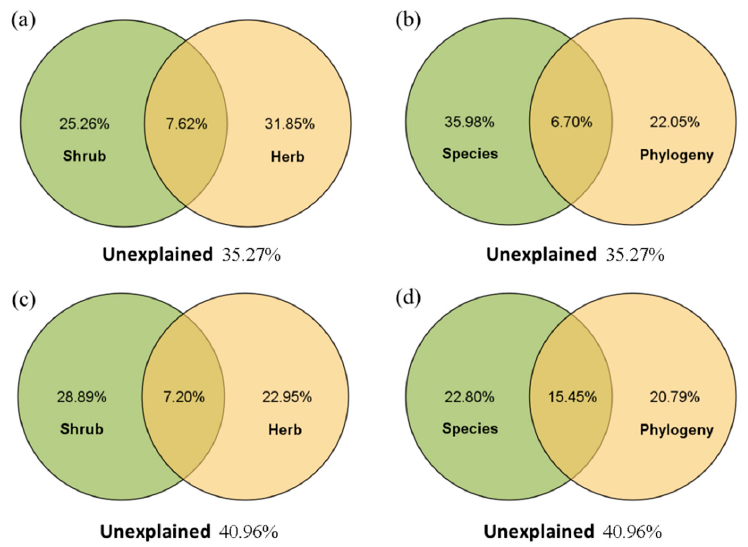
Figure 5. The variance component of soil nutrients explained by understory vegetation in the R. pseudoacacia forest ( a , b ) and P. tabuliformis forest ( c , d ). The overlap indicates a joint interpretation by the different groups.